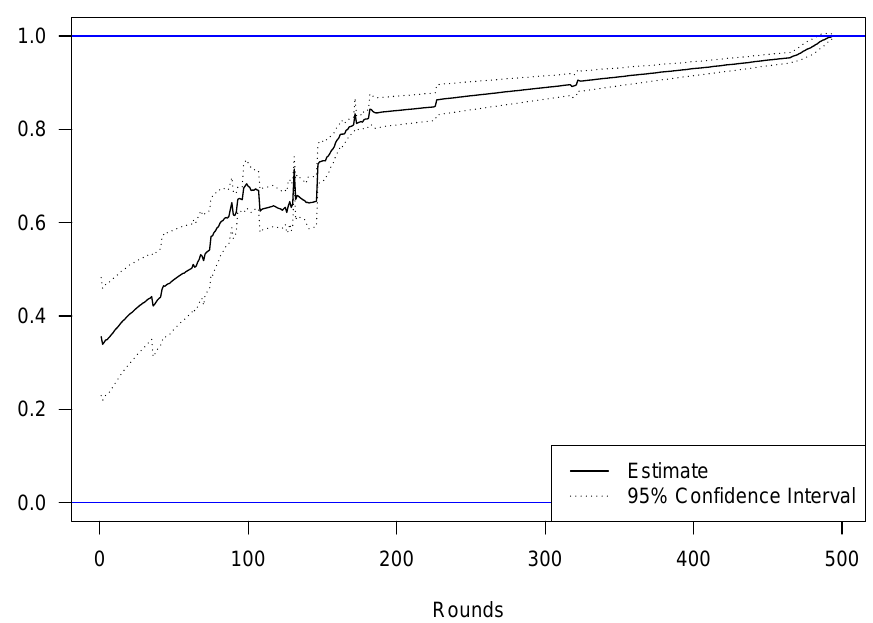
Figure 7. Estimate for ˆ β t using log returns . The graph shows the results from estimating ˆ β using log returns. The two blue lines indicate the noise hypothesis ( β = 0) and the learning hypothesis ( β = 1). The dotted lines represent the 95%-confidence interval based on robust standard